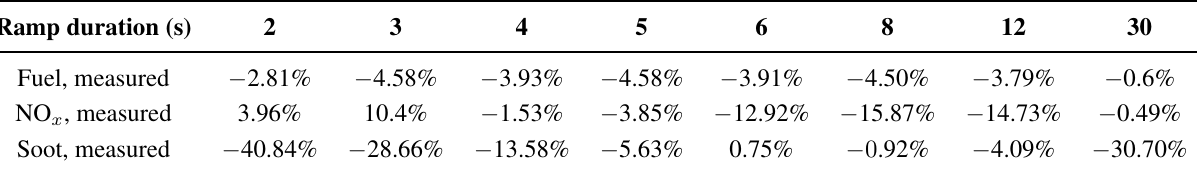
Table 3. Results of the dynamic optimization for each ramp. Relative changes between optimal and reference condition (average value over five